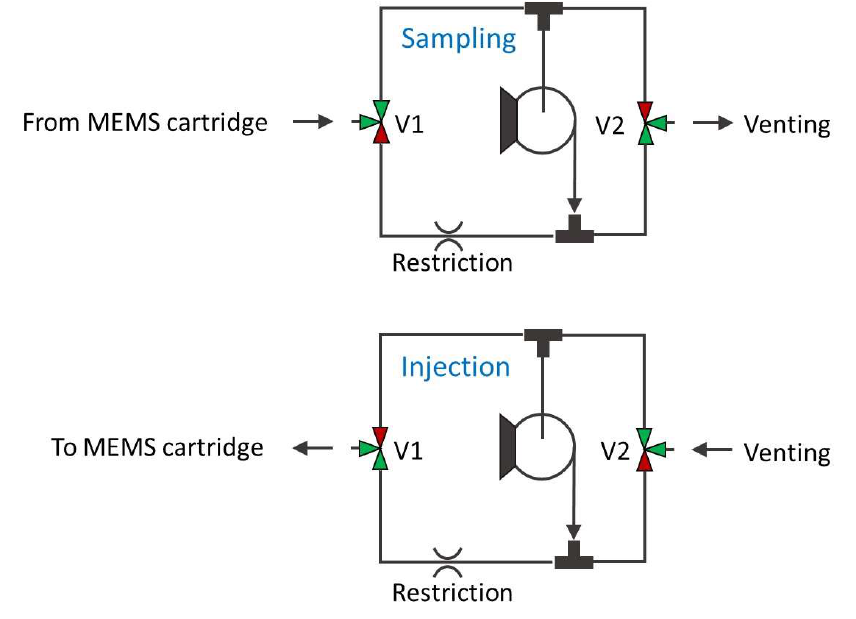
Figure 3. Schematics of the fluidic circuit of the sampling pump module.